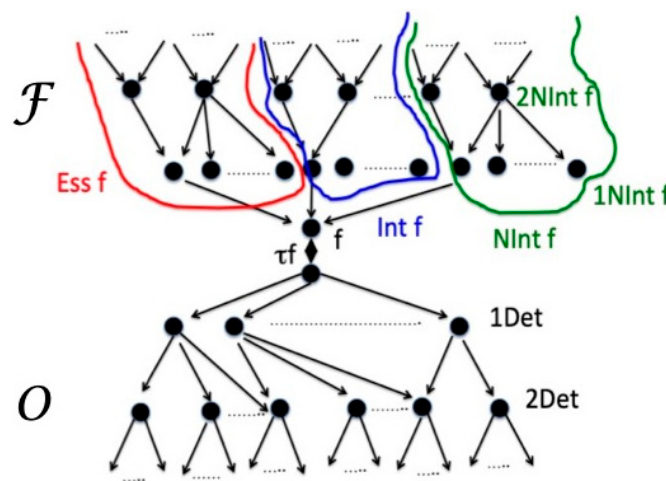
Figure 1. The preordered set model of the logic of determination of objects (LDO).